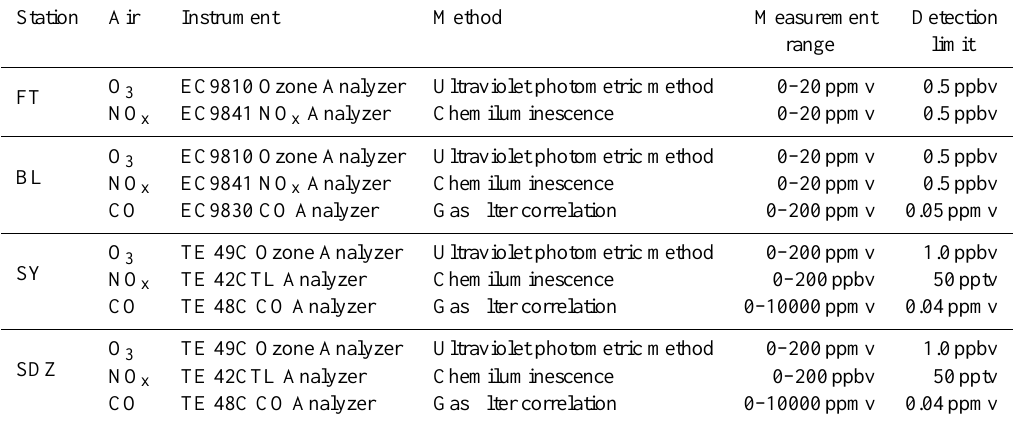
Table 1. Specifications of instruments and sampling methods.